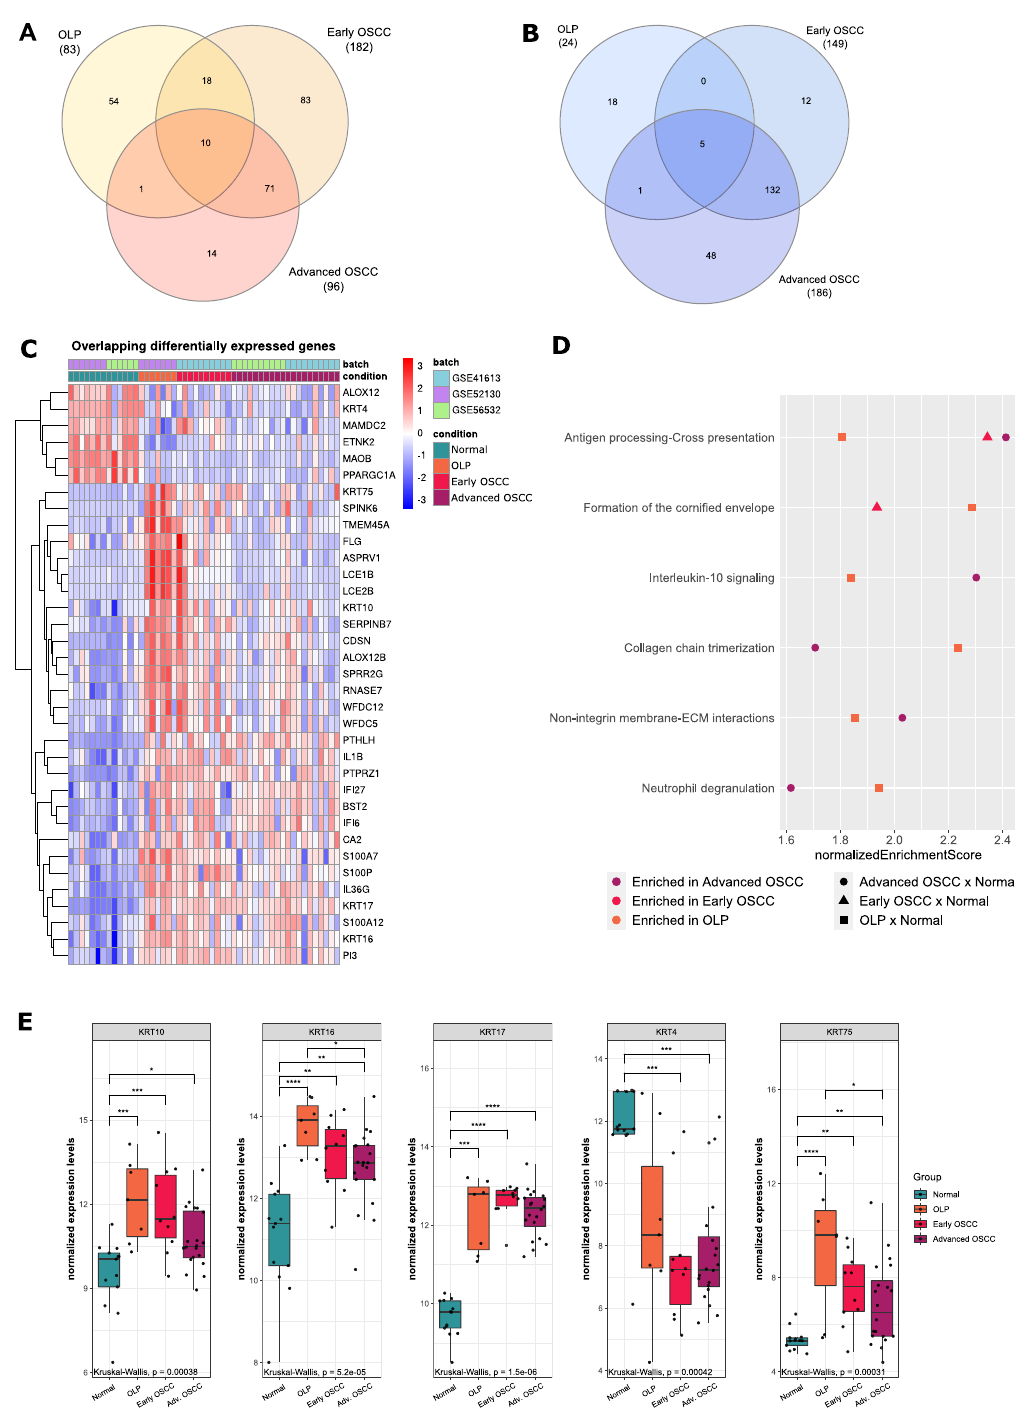
Figure 1. Differentially Expressed Genes between OLP, early, and advanced OSCC microarray datasets compared to normal oral tissue. ( A ) Venn diagram of overlapping DEGs of overexpressed genes. ( B ) Venn diagram of overlapping DEGs of underexpressed genes. ( C ) Clustered heatmap of DEGs shared between OLP, early, and advanced OSCC, as well as overexpressed genes shared by OLP and early OSCC. ( D ) Gene set enrichment analysis (GSEA) of Reactome pathways in Oral Lichen Planus (OLP), early, and advanced Oral Squamous Cell Carcinoma (OSCC). All pathways are up-regulated in comparison with normal tissue. For each pathway, orange squares, red triangles, and purple circles correspond to the normalized Enrichment Score for said pathway in OLP, early OSCC, and advanced OSCC, respectively. Only pathways enriched simultaneously in OLP and at least one of the OSCC stages are represented. ( E ) Differentially expressed keratin genes between OLP and both OSCC groups compared to normal tissue. Box plots represent the normalized expression distribution in each group. Comparisons among groups were made using the Kruskal–Wallis test followed by Dunn’s post-hoc test, with p-values lower than 0.05 considered significant for both tests. *p < 0.05; **p < 0.01; ***p < 0.001; ****p <